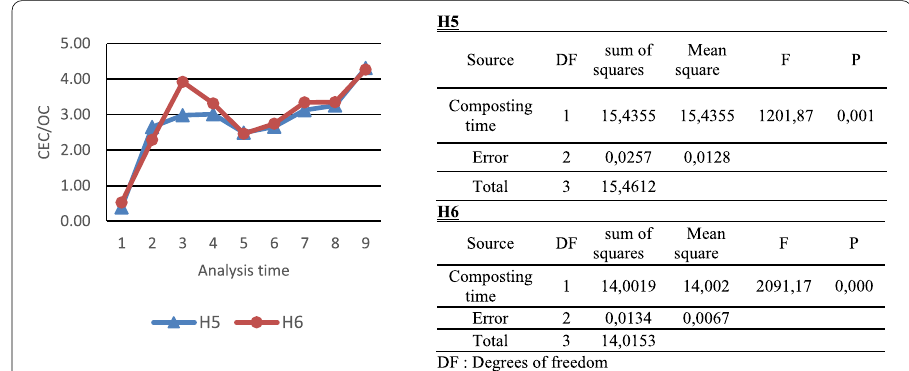
DF degrees of freedom, ASS adjusted sum of squares, SSS sequential sums of squares